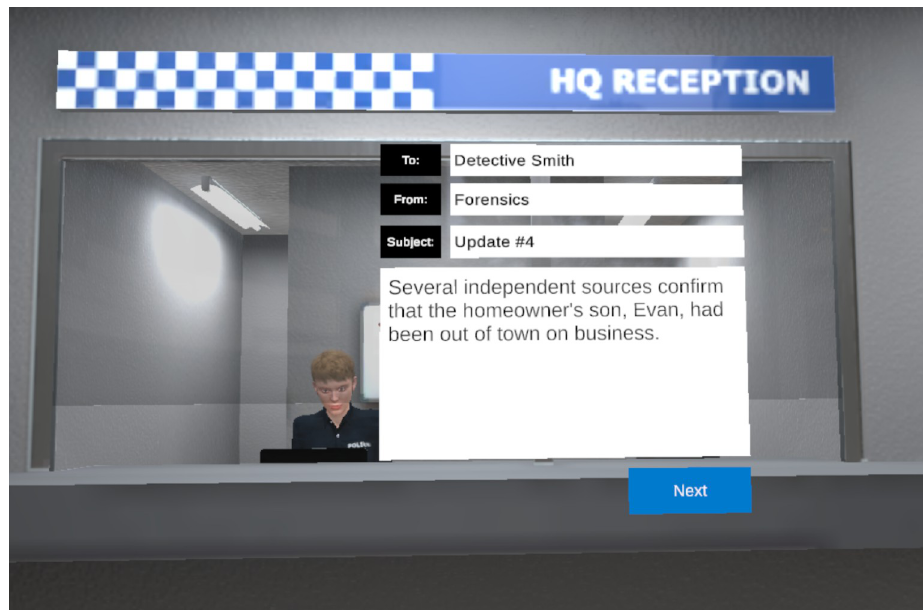
Fig 4. Example of Experiment 2’s retraction email in the shift